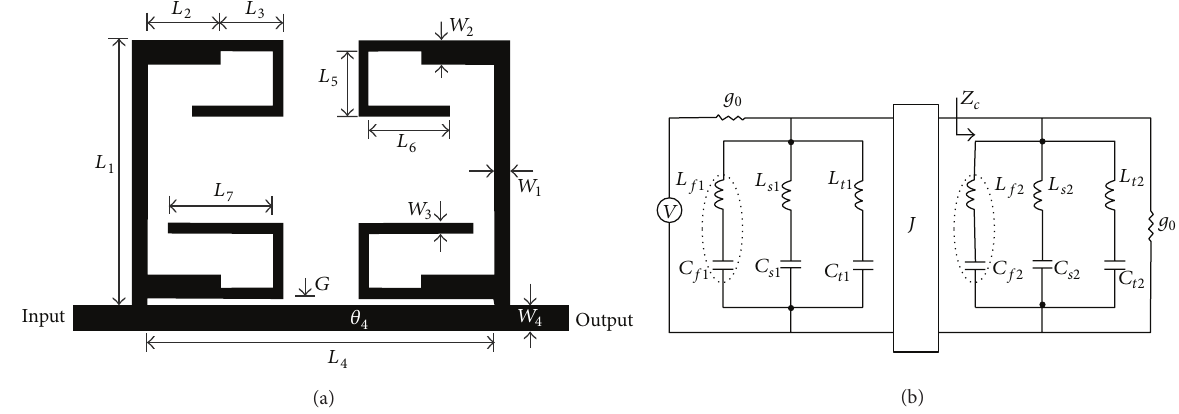
Figure3:(a)DesignlayoutoftheproposedTBBSFoforder, 𝑁 = 2 .(b)Equivalentcircuitintermsoftheshunt-connectedseries 𝐿𝐶 resonators and admittance (𝐽)